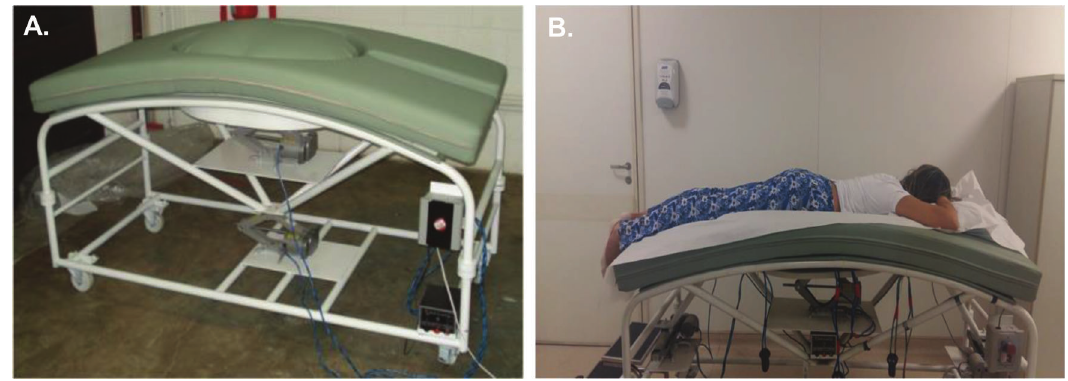
Figure 1 - A. Lateral view of the prototype of the stretcher that was specifically designed for pregnant women. National Industrial Intellectual Property Institute (INPI Brazil) – BR 10 2014 017147 9 and International - Patent Cooperation Treaty (PCT/BR2015/000103) B. A pregnant woman in the prone position on the stretcherwith cervical